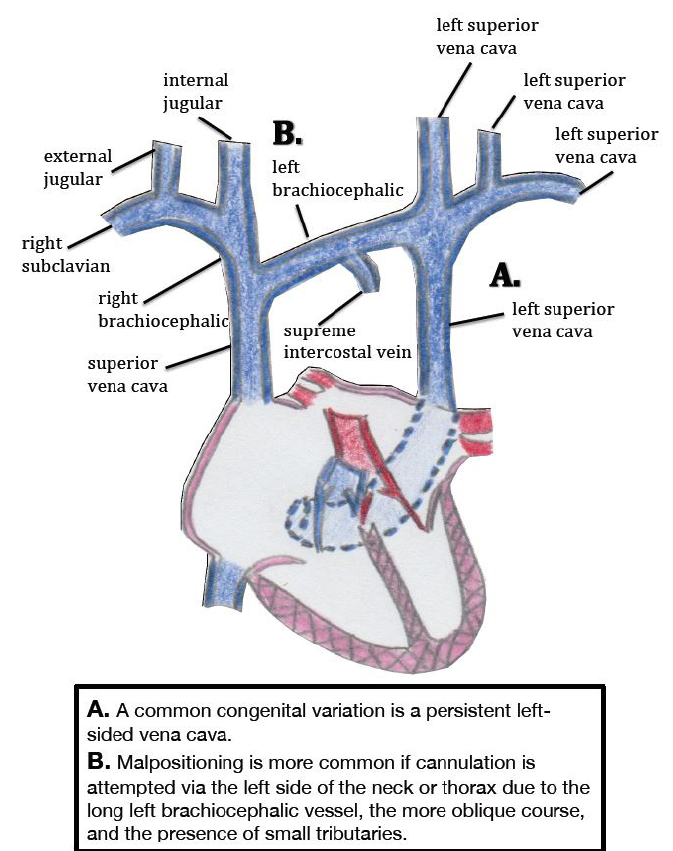
Figure 1. Common variants of clinical significance in the central venous anatomy, the congenital persistent left-sided superior vena cava.